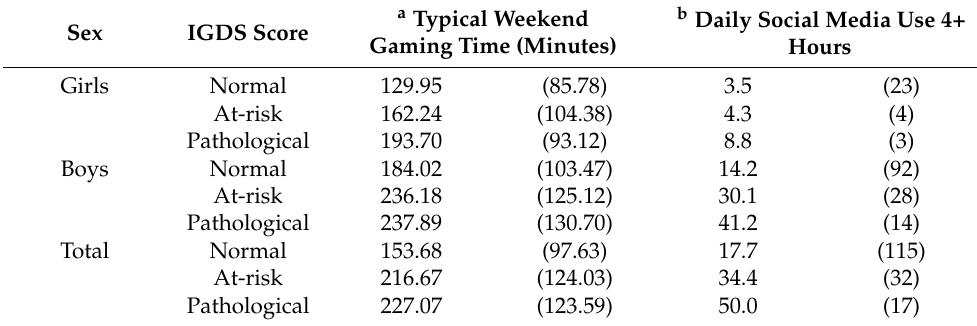
Table 5. Time spent with gaming (2016 sample, N = 762) and social media (2017 sample N = 777), depending on IGDS score.